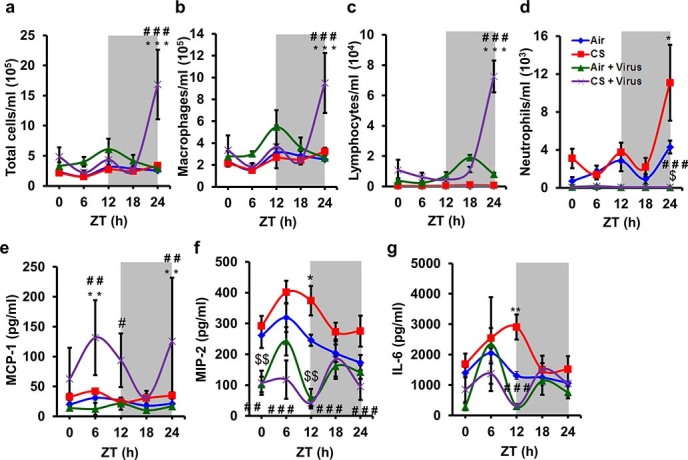
Chronic CS-exposed mice infected with influenza A virus show increased
inflammatory cell influx and proinflammatory cytokine release in BAL
fluid.Data from chronic (6 months) air- or CS-exposed mice given intranasal
inoculation of either saline (control group) or influenza A virus (IAV;
treatment group) at ZT4-6 are shown. Data from uninfected air- and
CS-exposed mice from a previous experiment were included for comparison
[panels a–d;30]. The
total number of inflammatory cells was determined in BAL fluid from air, CS,
Air+Virus and CS+Virus infected mice on day 9 post-infection. At least 500
cells in the BAL fluid were counted to determine (a) total cells,
(b) total macrophages, (c) total lymphocytes and
(d) total neutrophils. Data are representative of mean
± SEM (n = 3-4 mice/group) for each time point. * P
< 0.05, *** P < 0.001 significant compared to
air-exposed mice; $
P < 0.05 significant compared to air-exposed mice;
# # #
P < 0.001 significant compared to CS-exposed mice. Levels
of proinflammatory mediators (e) MCP-1, (f) MIP-2 and
(g) IL-6 levels were measured in BAL fluid obtained from air, CS,
Air+Virus and CS+Virus infected mice. IAV infection of chronic CS-exposed
mice alters diurnal rhythms of proinflammatory cytokine release in mouse
lungs. Data are representative of mean ± SEM (n = 3-4 mice/group)
for each time point. * P < 0.05; ** P <
0.01; *** P < 0.001 significant compared to air or
Air+Virus groups; #
P < 0.05; # #
P < 0.01; # # #
P < 0.001 significant compared to CS-exposed mice.